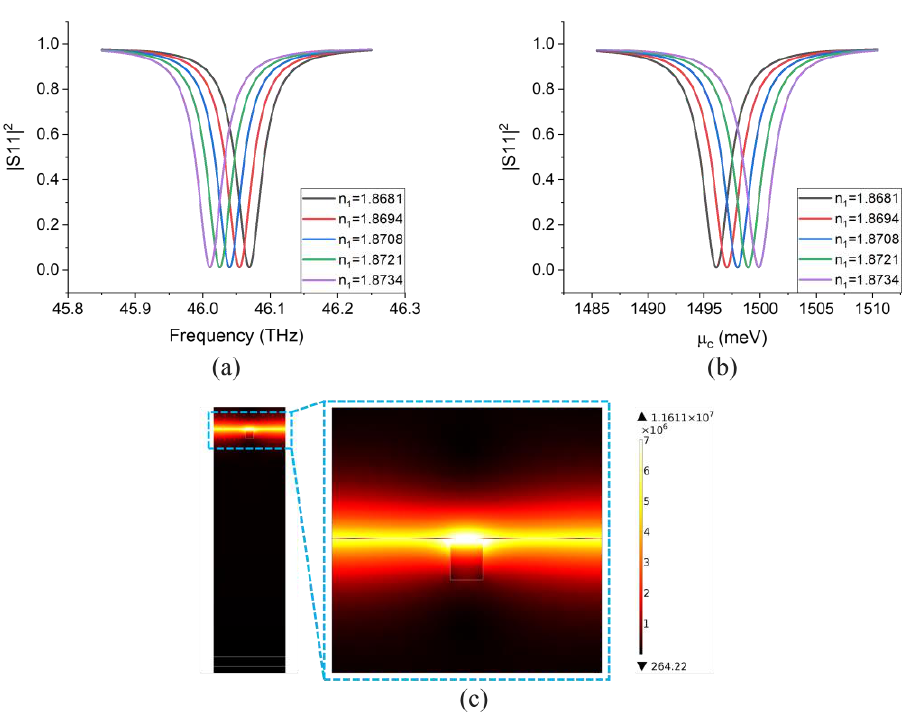
Figure 6. ( a ) Reflection coe ffi cient for the sensor (with reflector) working in the optical mode of operation with µ c = 1500 meV. ( b ) Reflection coe ffi cient for the same device working in the electrical mode with the same chemical potential. ( c ) Simulated electric field intensity at GSPR peak for (cid:15) 1 = 3.5 ( n 1 = 1.87 ).